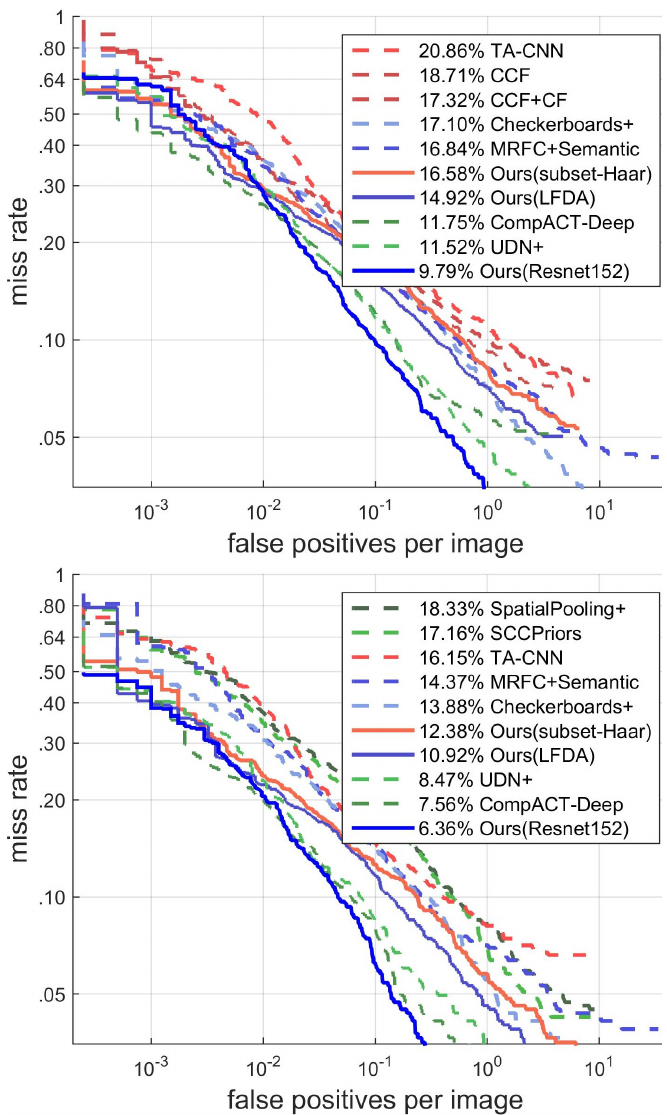
Figure 5. The performance comparison of different methods on the Caltech dataset. Uppper : original annotation, Down : new